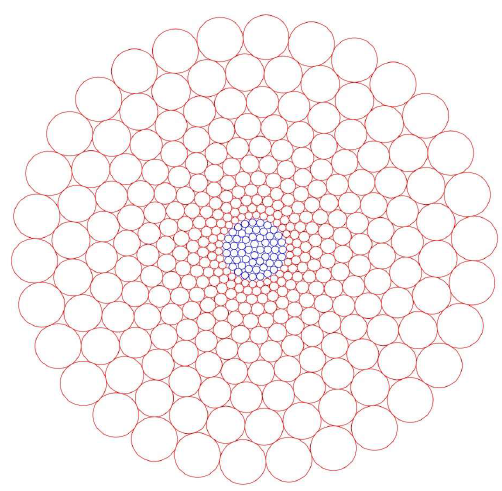
Figure 12. Log-polar layout of receptive fields with the periphery colored red and fovea colored blue.